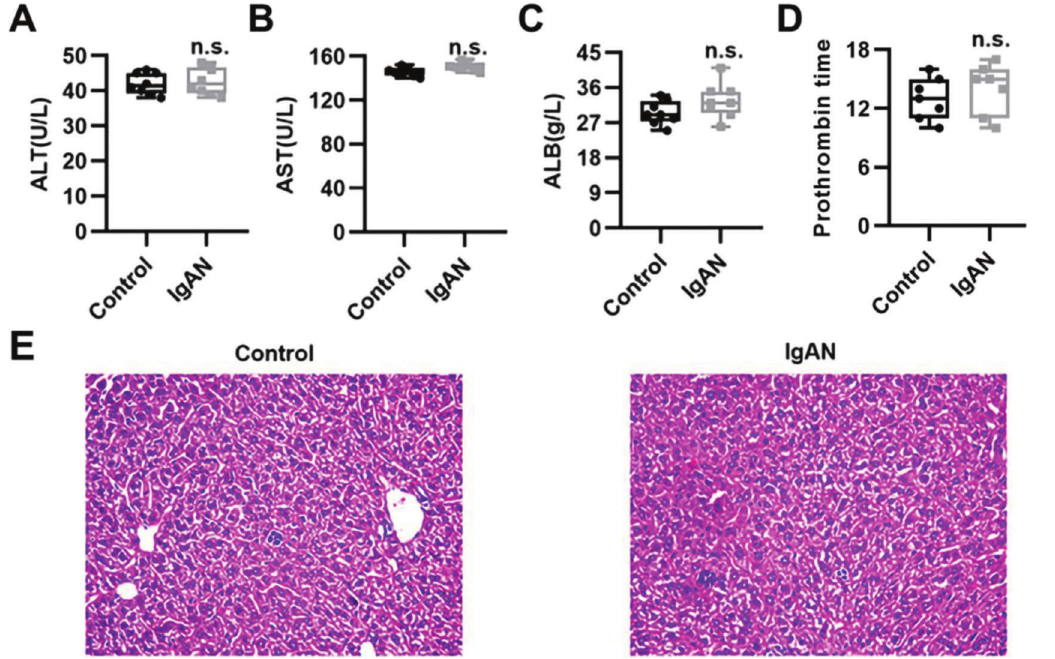
Figure S1 - Construction of IgAN rat model had no impact on the liver. (A-D) The IgAN rats constructed by CCl4 method showed no obvious abnormality of ALT (A), AST (B), ALB (C) and PT indicators (D). (E) The results of HE staining. ALT: alanine aminotransferase, AST: aspartate aminotransferase, ALB: albumin, IgAN: Immunoglobulin A